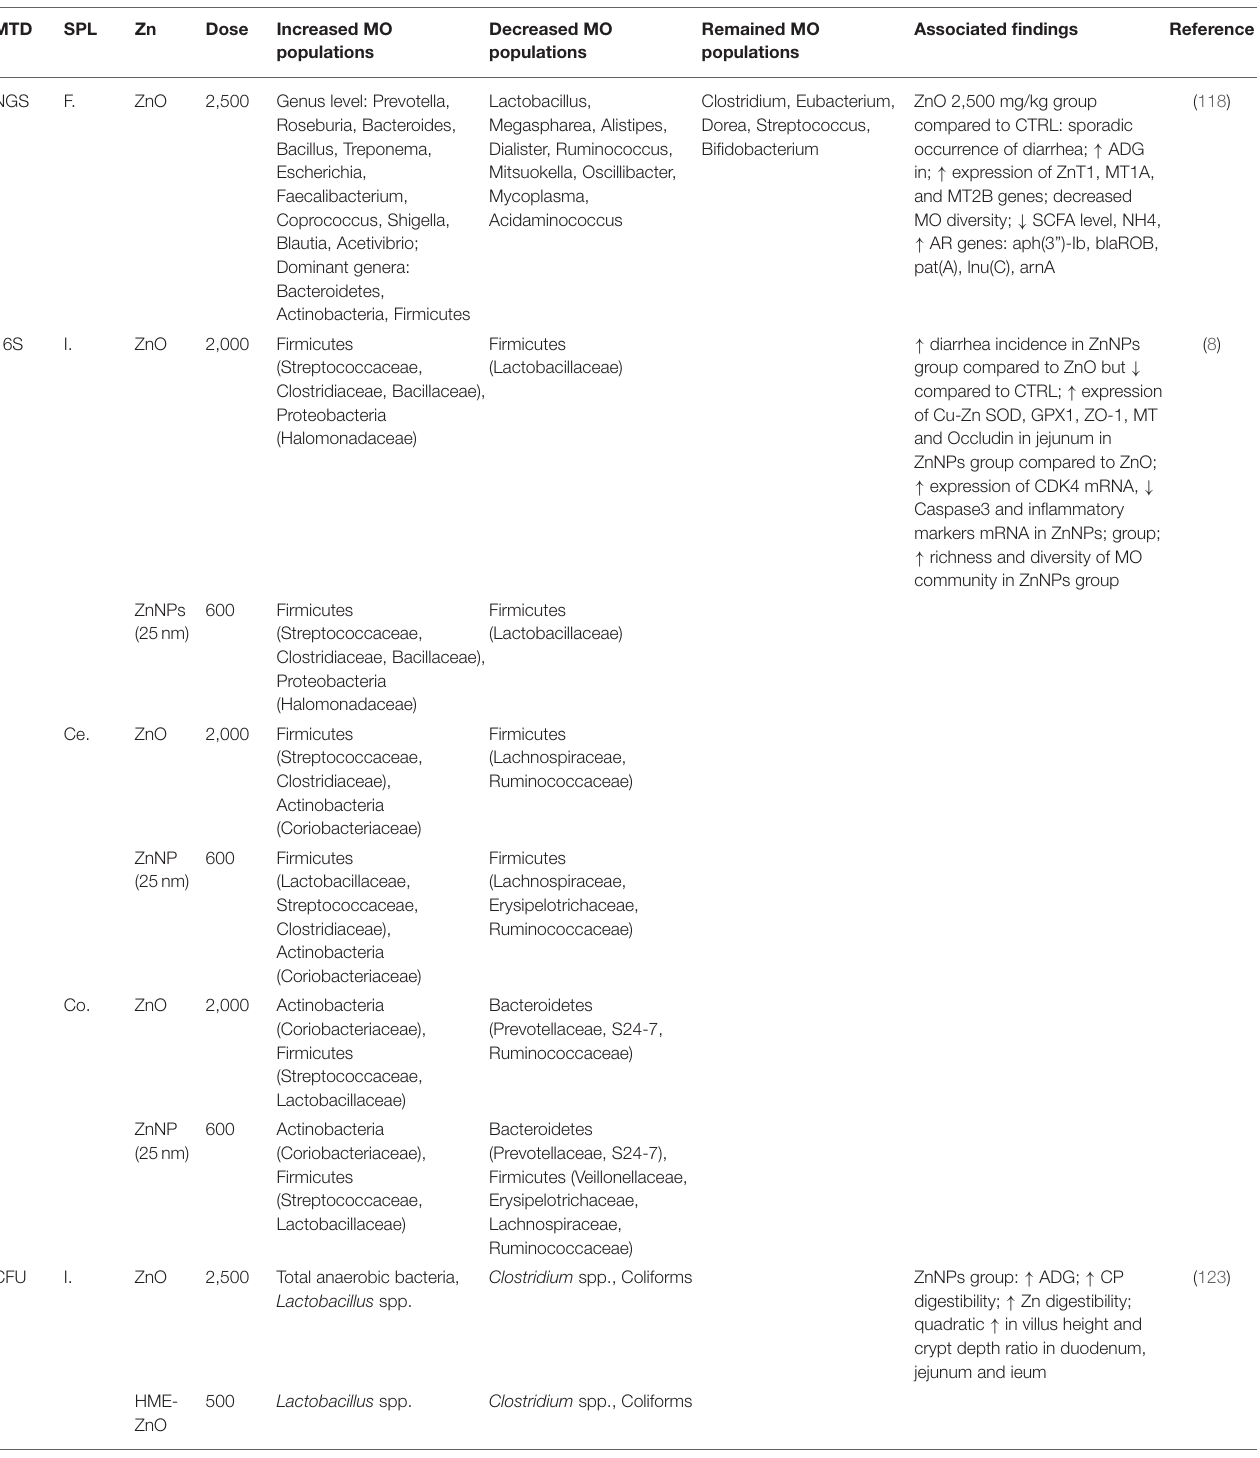
TABLE 1 | Comparison of ZnO and ZnNP effects on pig